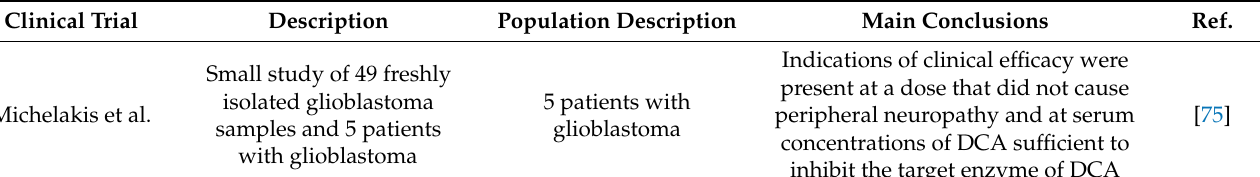
Table 1. Summary of phase I/II clinical trials of DCA in